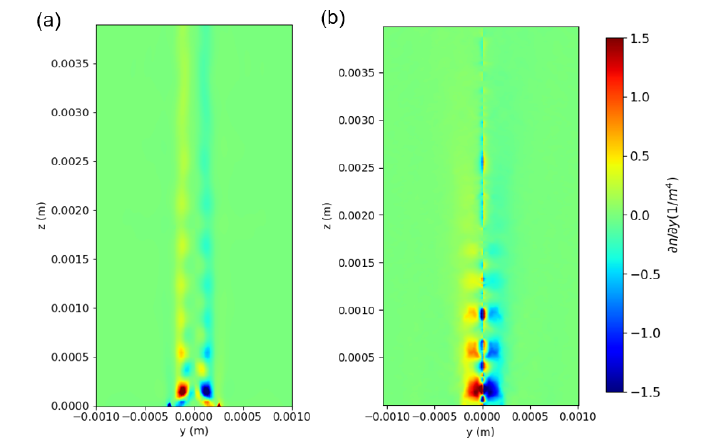
Figure 10. Two-dimensional map of the gradient of the refractive index, ∂ n / ∂ y , based on the ( a ) simulated result and ( b ) reconstructed data. Here, y and z are the horizontal and vertical coordi- nates,